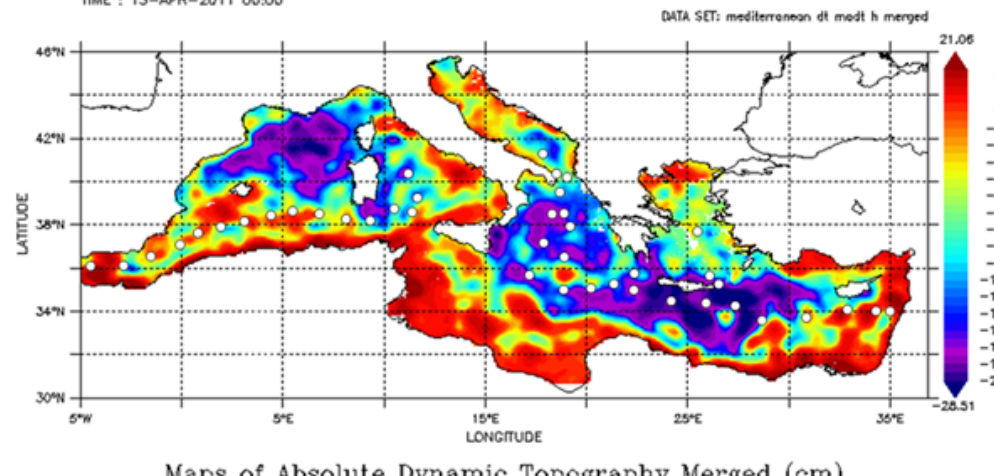
Fig. 2. Absolute Dynamic Topography (ADT) map of the Mediterranean averaged over the second half of April